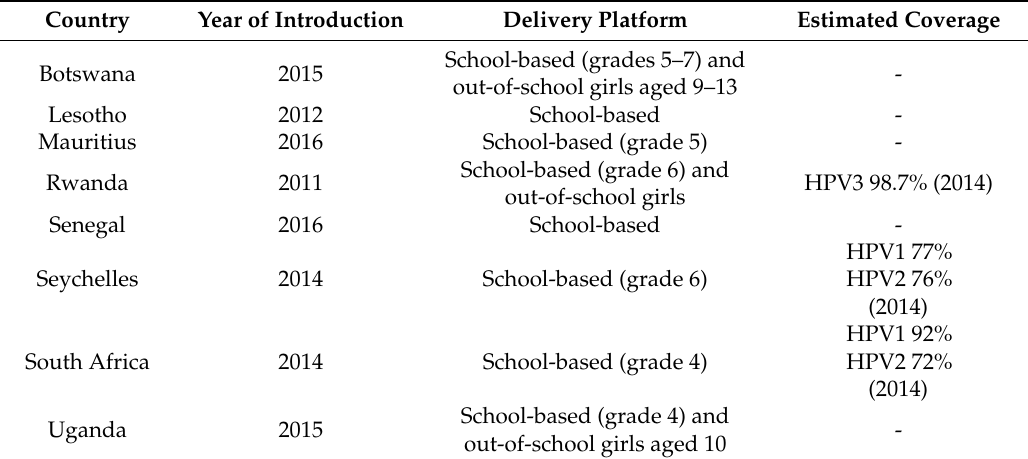
Table 2. National HPV Immunization Programs in SSA